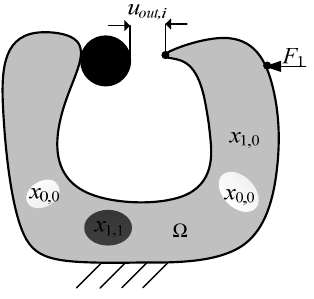
Figure 2. The design model of multi-material compliant mechanisms.